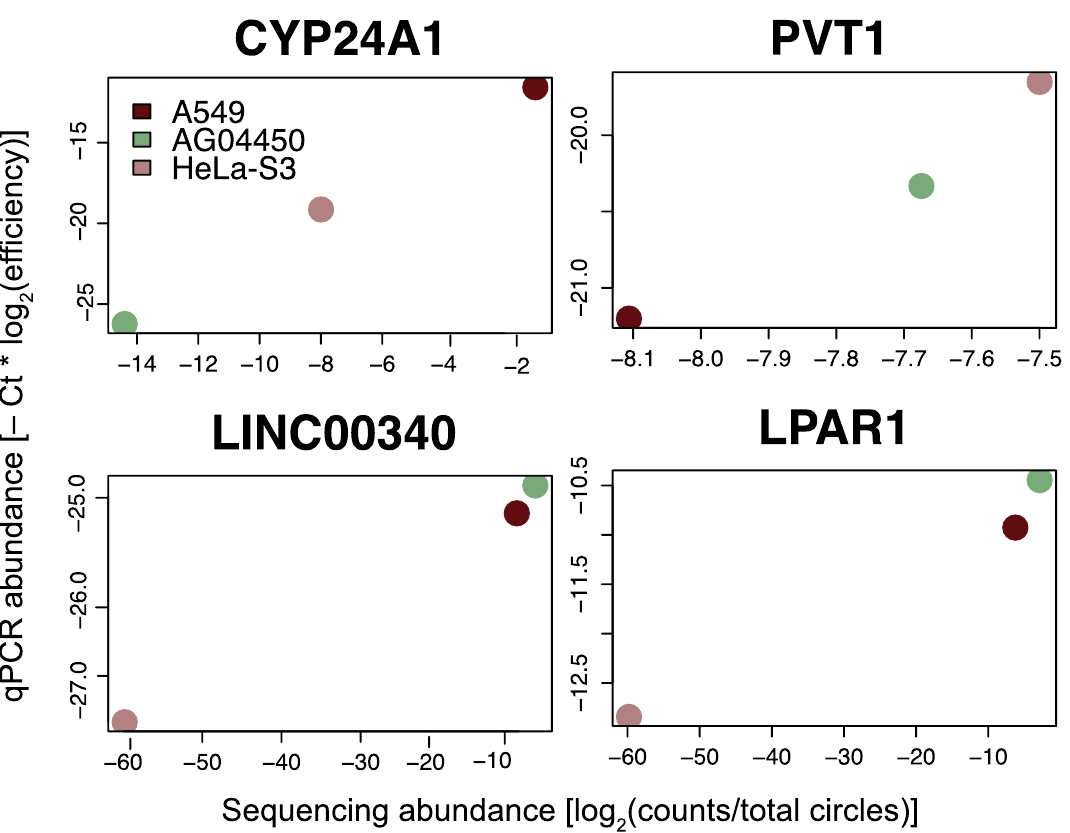
Figure 5. qPCR validation of relative circular RNA expression across cell type. Total RNA from A549, AG04450 and HeLa cells was probed by qPCR using primers specific for circular isoforms of the indicated genes, and abundances were normalized using primer efficiencies estimated with a dilution series. Sequencing-based estimates are shown by comparison; sequencing values are depicted as a log fraction of total circle counts per experiment. Each qPCR and sequence value is calculated from the average of two biological replicates. Expression of LINC00340 and LPAR1 in HeLa is not detectable with the sequencing depth in this data, and these values were pinned at 2 60 on the log scale.